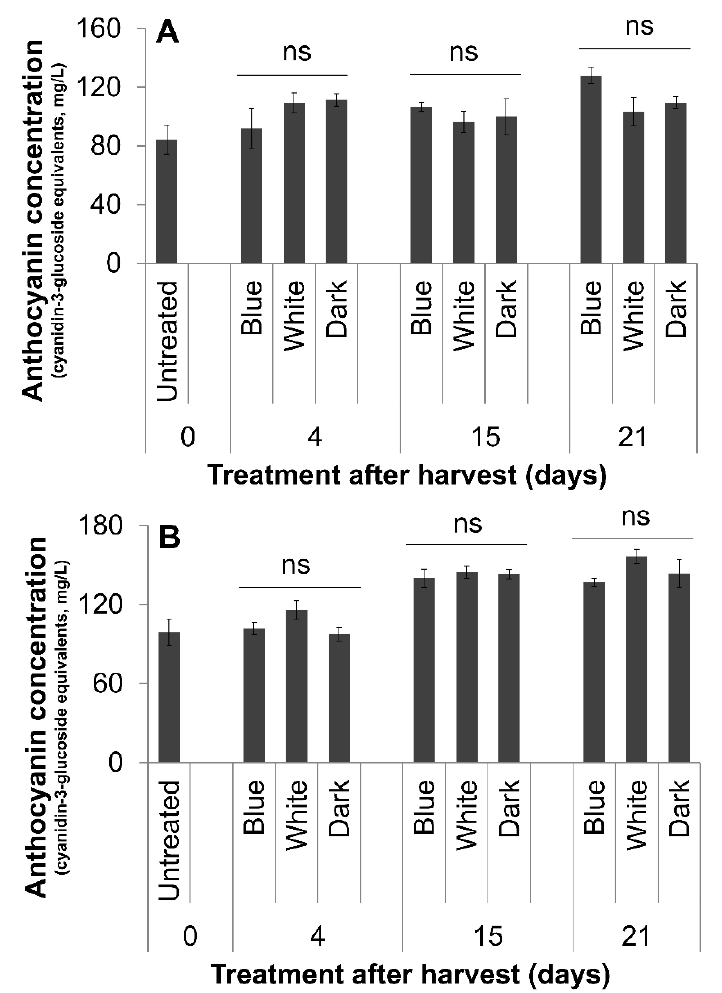
Figure 2. Anthocyanin concentration (expressed as cyanidin-3-glucoside equivalents) under different light treatments in ripe ‘Star’ ( A ) and ‘Alapaha’ ( B ) blueberries in cold storage. An initial fruit quality assessment was performed prior to treatment initiation (day 0). One-way analysis of variance was performed between the three treatments (blue, white and dark) separately for each time point after treatment. ns = non-significant (α = 0.05). Table 3. Color values in ripe ‘Star’ southern highbush blueberries subjected to light treatments at various times during cold storage.